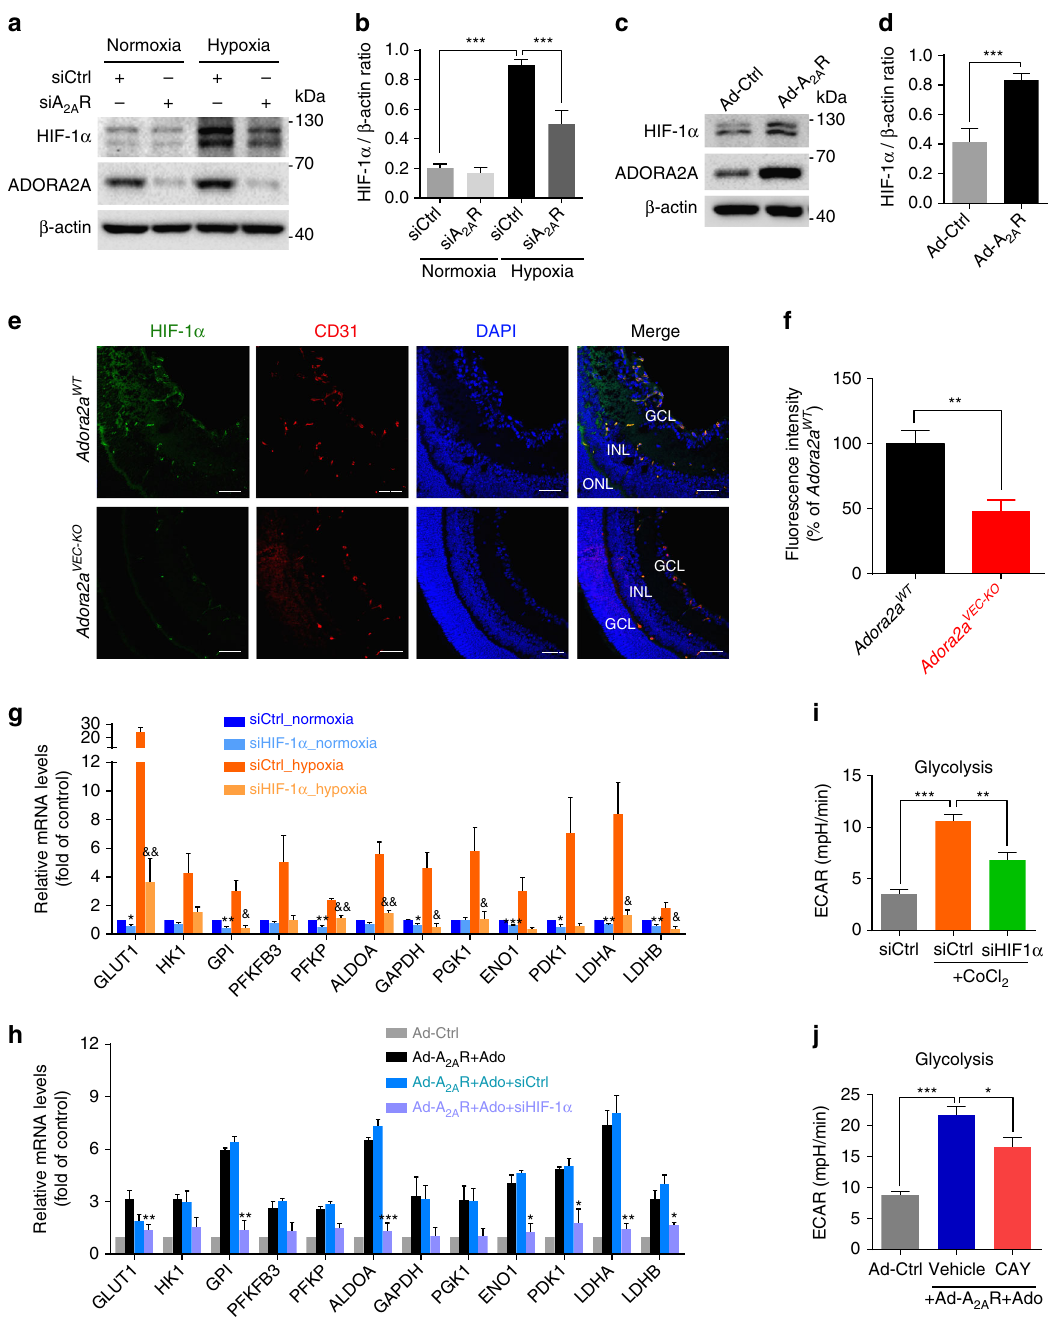
Fig. 8 ADORA2A activation mediates increase in glycolysis via a HIF-1 α -dependent pathway. a – d Western blot analysis of HIF-1 α mRNA and protein expression in HRMECs transfected with siA 2A R or siCtrl under hypoxia (0.5% O 2 ) or normoxia (21% O 2 ) a , b , or infected with Ad-Ctrl or Ad-A 2A R under normoxia c , d . n = 4. *** P < 0.001. e , f HIF-1 α immuno fl uorescent staining of OIR retinas from Adora2a WT and Adora2a VEC-KO mice at postnatal day (P)15. Representative green (HIF-1 α ), red (CD31), blue (nuclei, DAPI), and merged images captured with confocal fl uorescent microscopy. GCL ganglion cell layer, INL inner nuclear layer, ONL outer nuclear layer. Scale bar , 50 μ m. The fl uorescence intensity of HIF-1 α staining was calculated by Image J software then normalized to that of WT control ( Adora2a WT ). n = 6 mice for each group. ** P < 0.01. g Real-Time PCR analysis of the mRNA levels of glycolytic genes in HRMECs transfected with siHIF-1 α or siCtrl under normoxia (21% O 2 ) or hypoxia (0.5% O 2 ). n = 3. * P < 0.05; ** P < 0.01; *** P < 0.001 vs. siCtrl normoxia group; & P < 0.05; && P < 0.01 vs. siCtrl hypoxia group. h Real-Time PCR analysis of the mRNA levels of glycolytic genes in HRMECs. Cells were transfected with HIF-1 α siRNA or siCtrl for 24 h under normoxia, and further infected with Ad-A 2A R or Ad-Ctrl for an additional 24 h, followed by adenosine treatment for another 12 h. n = 4. * P < 0.05; ** P < 0.01; *** P < 0.001 vs. Ad-A 2A R + Ado + siCtrl group. i Quanti fi cation of glycolytic function in HRMECs transfected with siCtrl or siHIF-1 α in the presence of CoCl 2 (200 μ M). n = 8 per group. * P < 0.05; *** P < 0.001. j Quanti fi cation of glycolytic function in HRMECs infected with Ad-Ctrl or Ad-A 2A R, with or without adenosine treatment, in the presence or absence of the HIF-1 α inhibitor CAY10585. n = 7, 7, 6, respectively. * P < 0.05; *** P < 0.001. Data are represented as means ± s.e.m. Statistical signi fi cance was determined by unpaired Student ’ s t -test (for d , f , g , h ) and one-way ANOVA followed by Bonferroni test (for b , i , j